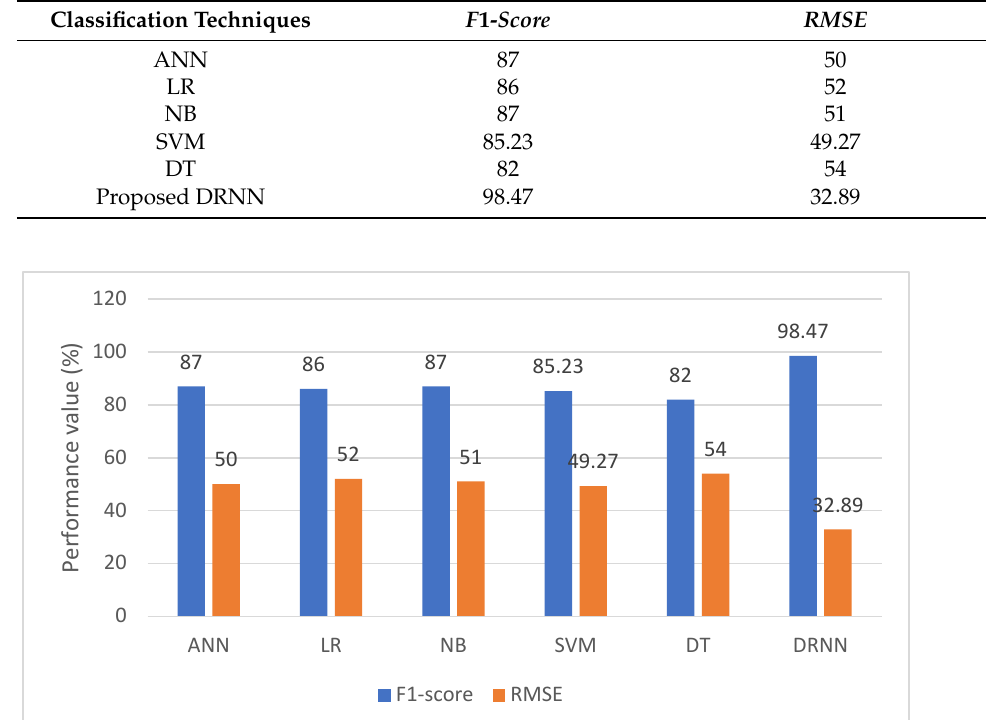
Figure 6. RMSE and F1-score of both existing and proposed techniques.